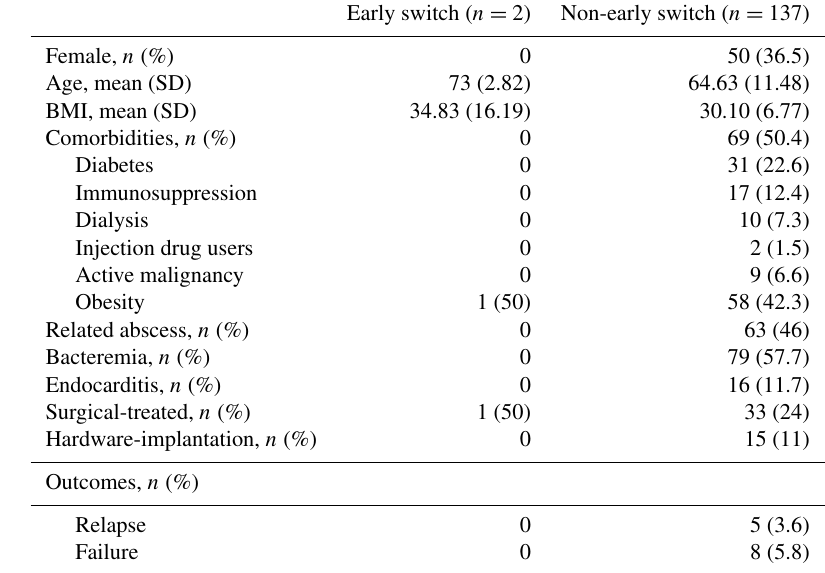
Table 1. Demographic and clinical characteristics of Mayo patients with bacterial NVO between 2019–2021.